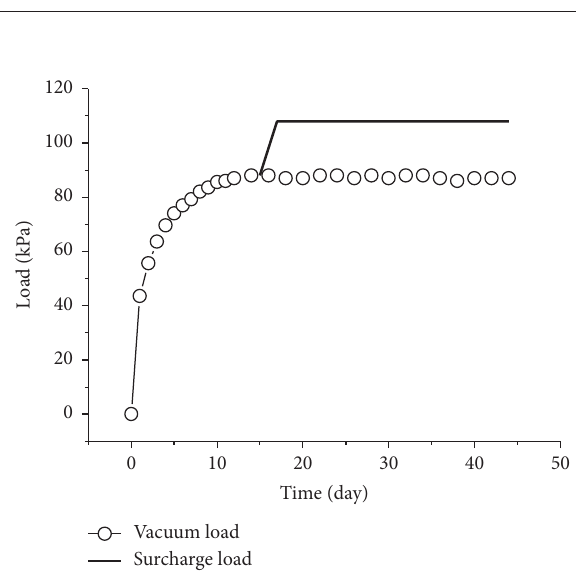
Figure 4: Vacuum degree under geomembrane and surcharge